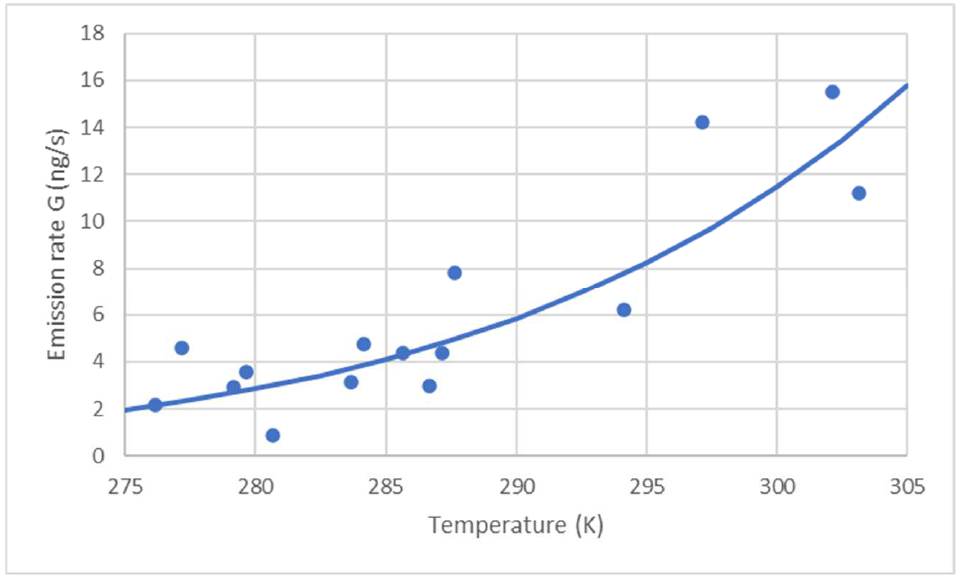
Figure 8. Emission Rate vs. temperature values derived from measurements (dots) and calculated with model based on Arrhenius theory (line).